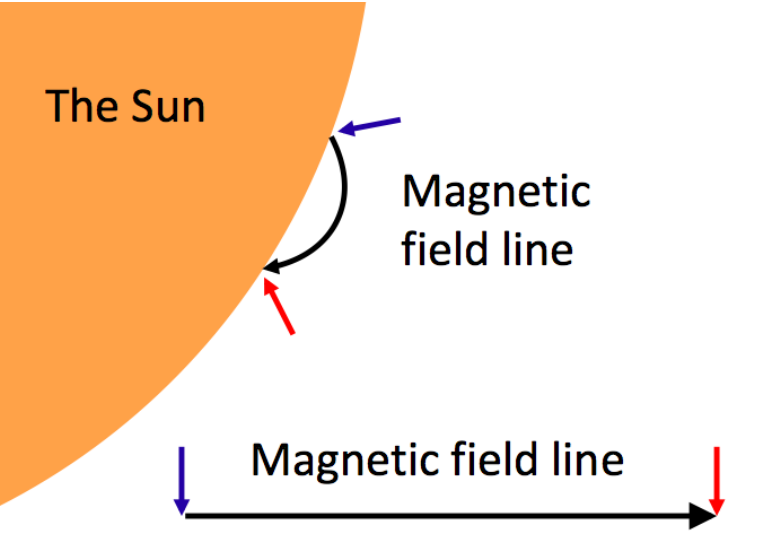
Figure 1. A depiction of the simplification of the closed field lines of the magnetic field of the Sun. The curved magnetic field line is straightened so that geometrical factors can be ignored in the simulation. The colored arrows indicate the injection points of wave energy to the magnetic field line, blue being the parallel wave mode injection point and red being the anti-parallel wave mode injection